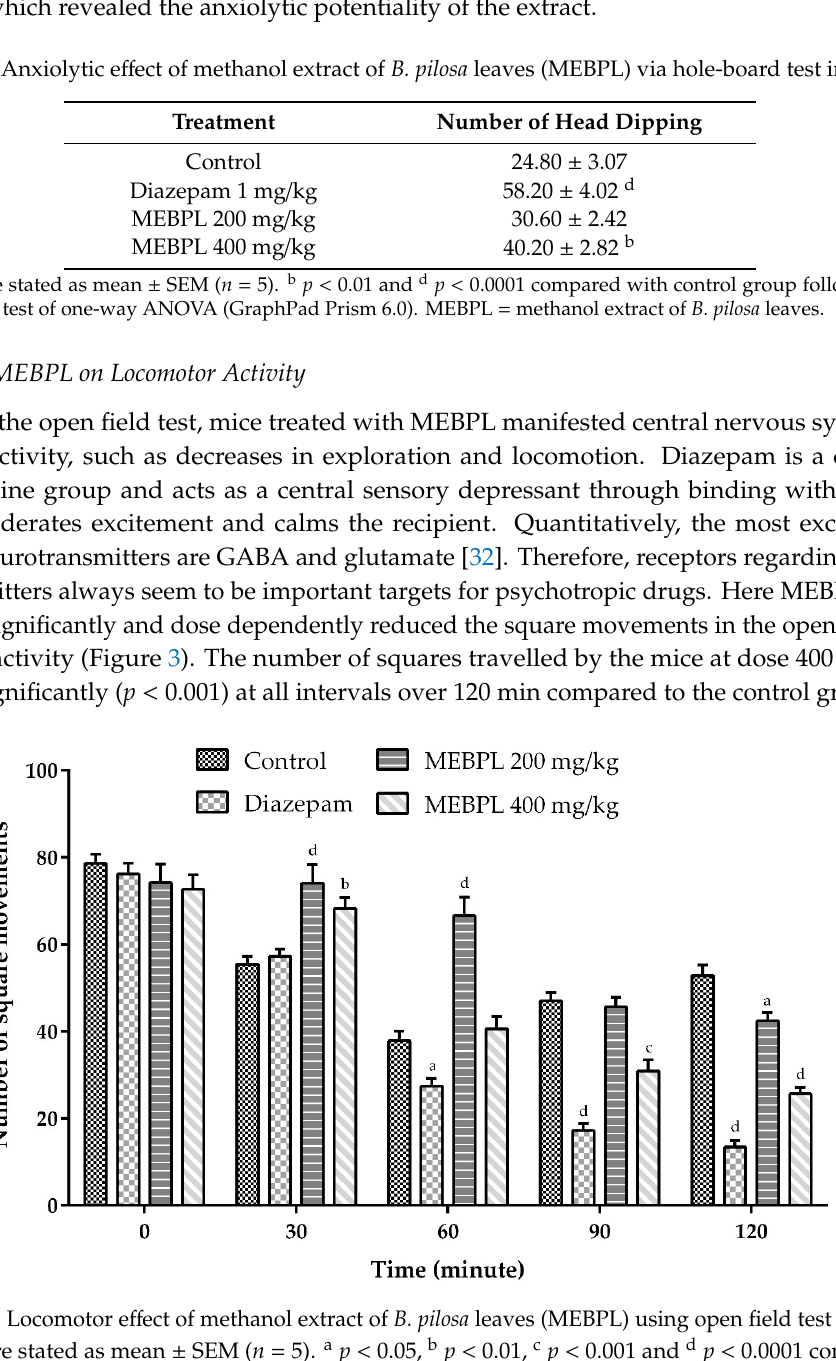
Figure 3. Locomotor effect of methanol extract of B. pilosa leaves (MEBPL) using open field test